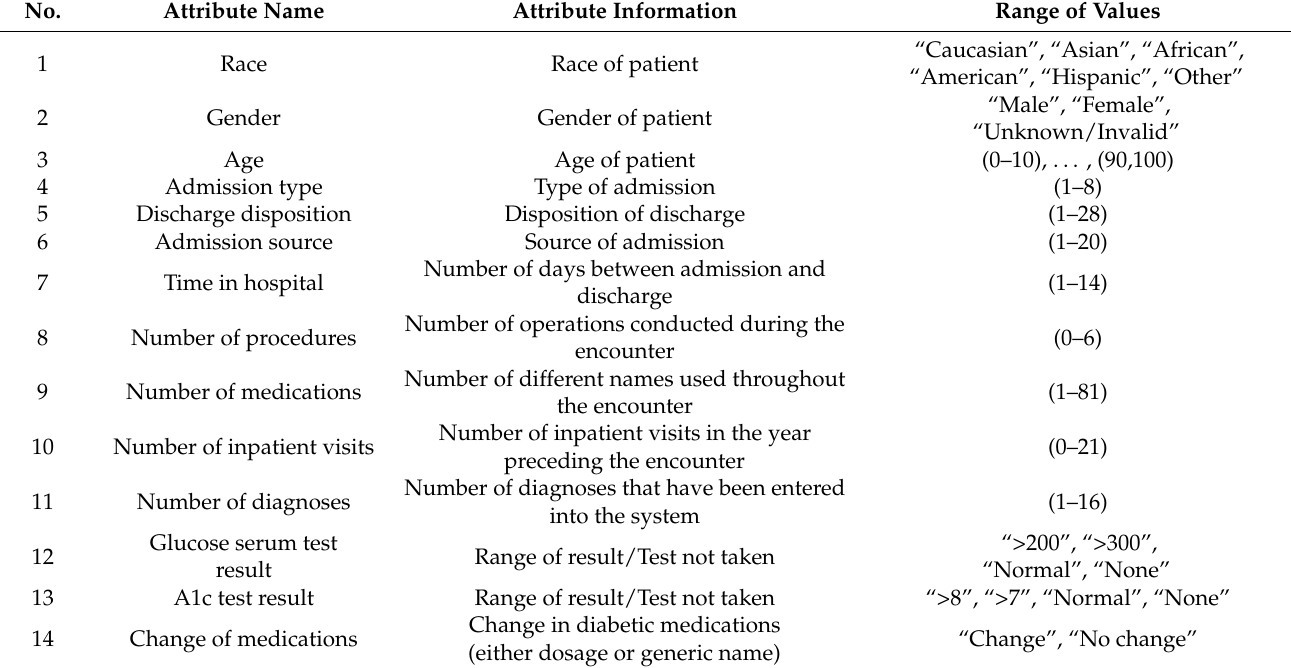
Table 1. Dataset description of diabetes.